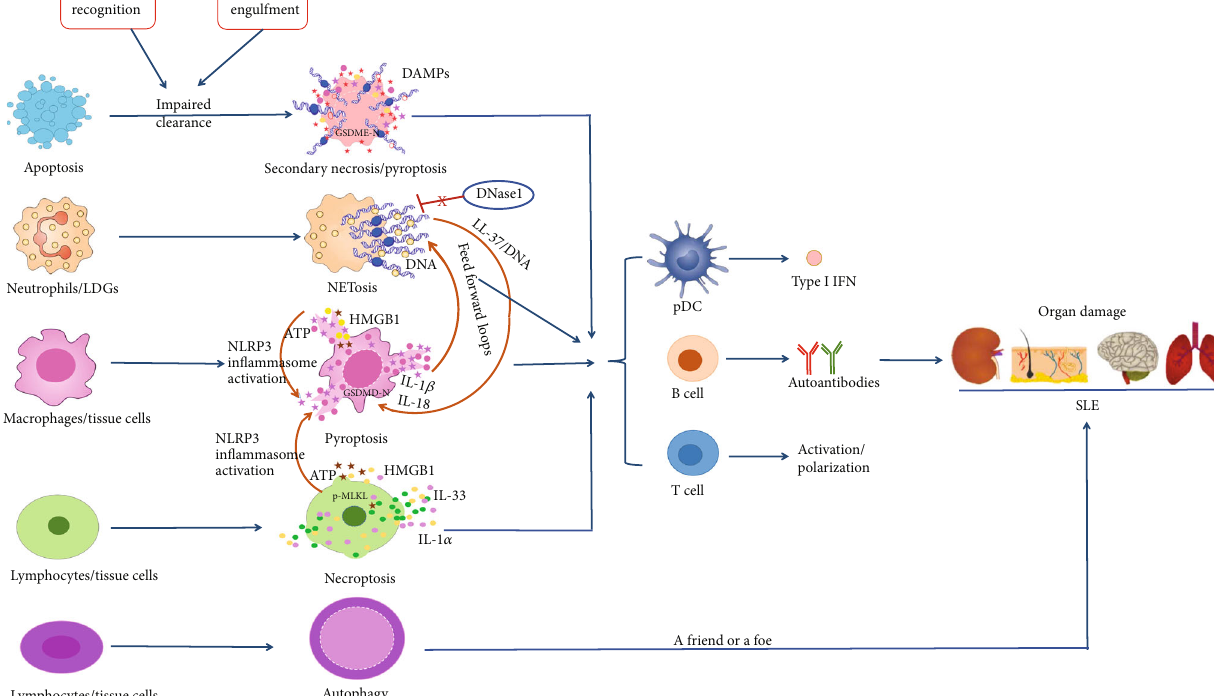
Figure 1: Programmed cell death pathways in the pathogenesis of systemic lupus erythematosus. Cell death recognition model for the immune system: consequence of immune responses, tolerance or adaptive immune responses, are dependent on the ways of cell death. Apoptosis results in immune tolerance, while lytic cell death (such as secondary necrosis, NETosis, pyroptosis, and necroptosis) contributes to the release of damage-associated molecular patterns (DAMPs), ampli fi cation of in fl ammatory and immune responses, production and release of autoantigens, and tissue damage in